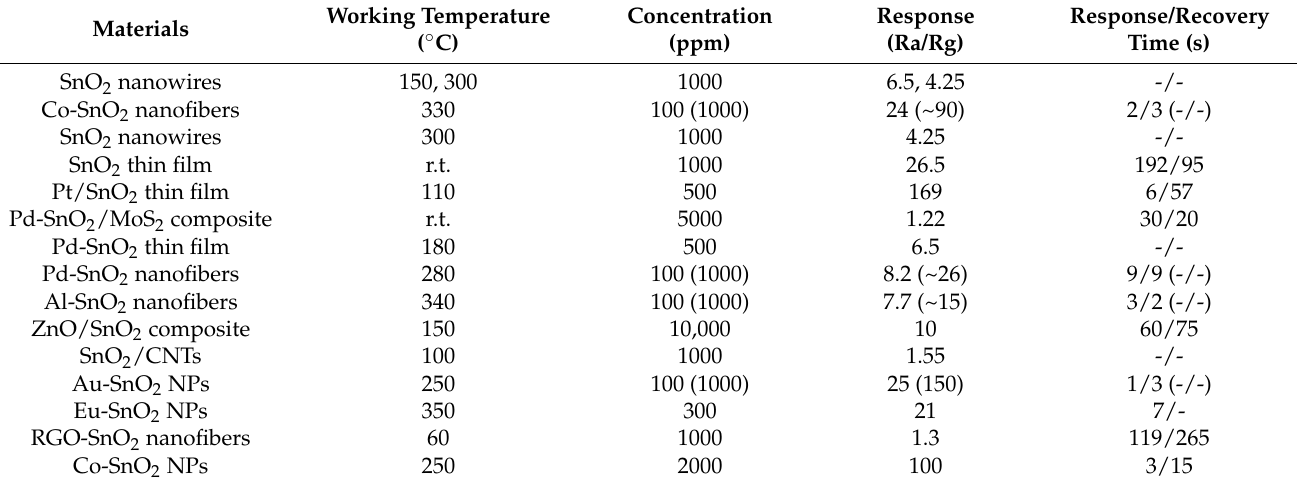
Table 1. Comparison of the sensing characteristics of SnO 2 -based conductometric hydrogen sensors. Reprinted from International Journal of Hydrogen Energy, Vol 42, Lavanya N. et al., Development of a selective hydrogen leak sensor based on chemically doped SnO 2 for automotive applications, Pages No. 10645–10655, Copyright (2017), with permission from Elsevier [87].